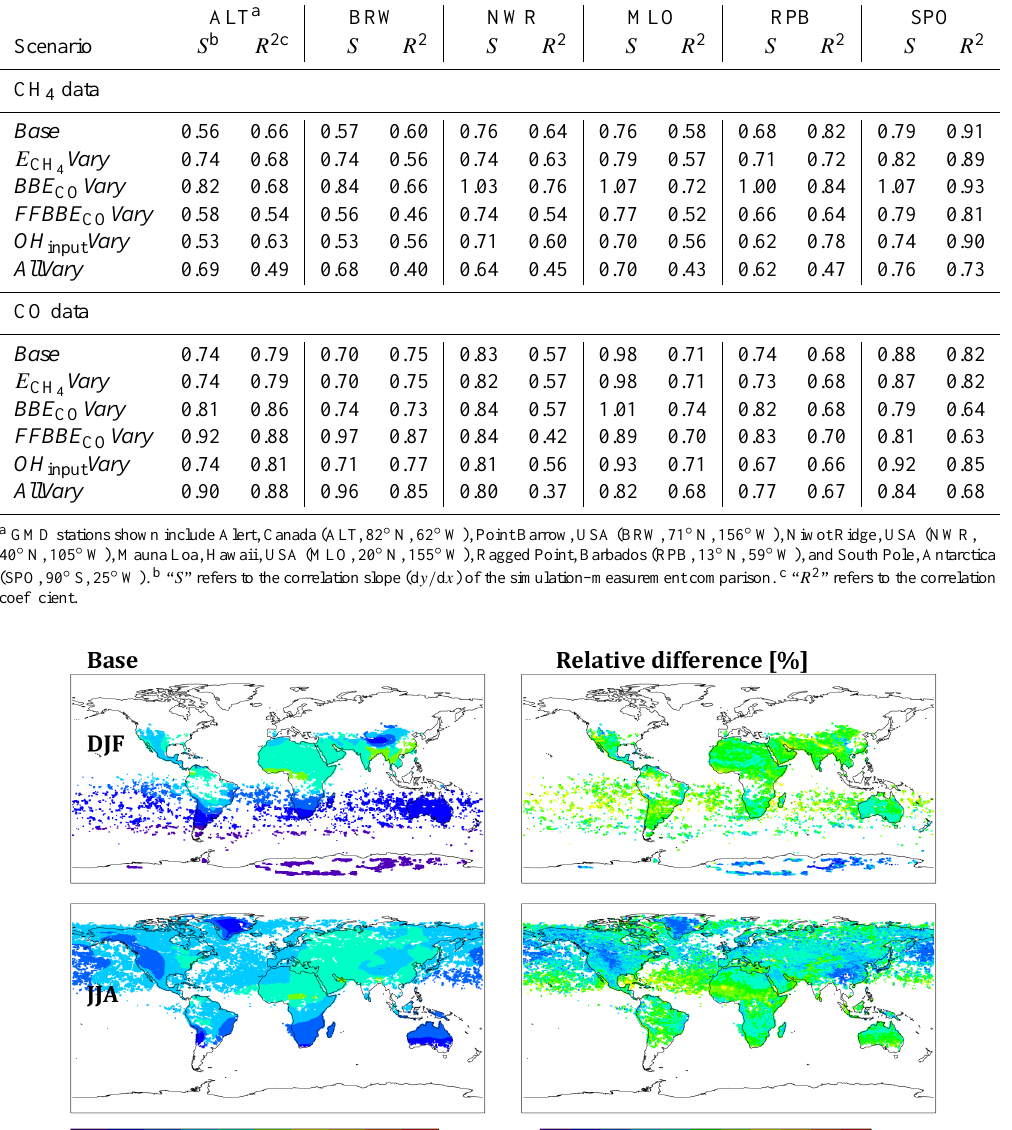
Table 4. List of the correlation parameters of the different model scenarios and the monthly GMD measurements for the simulation period (1988–2007).